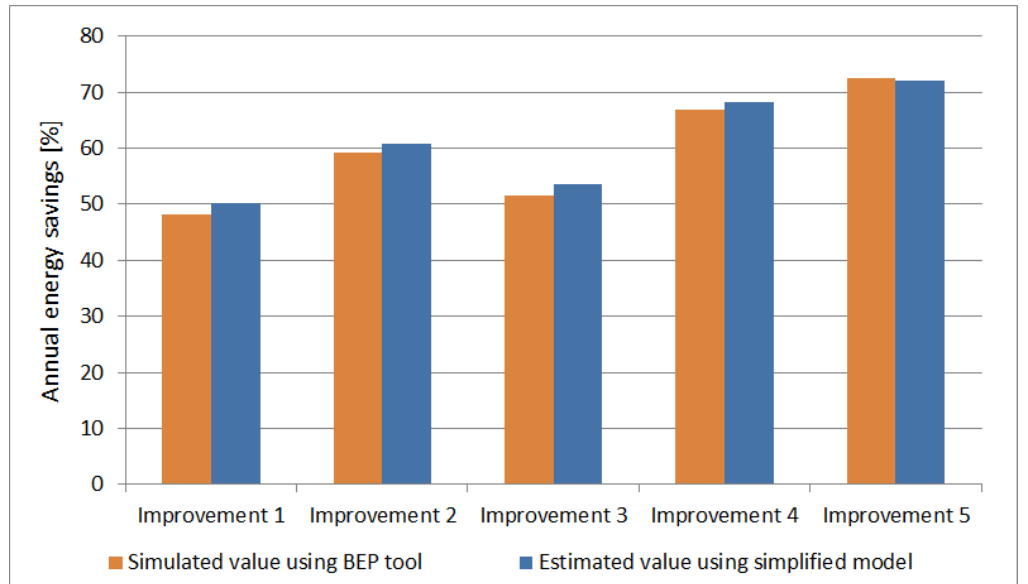
Figure 10. Annual comparison of the savings simulated and estimated from the heating season model.